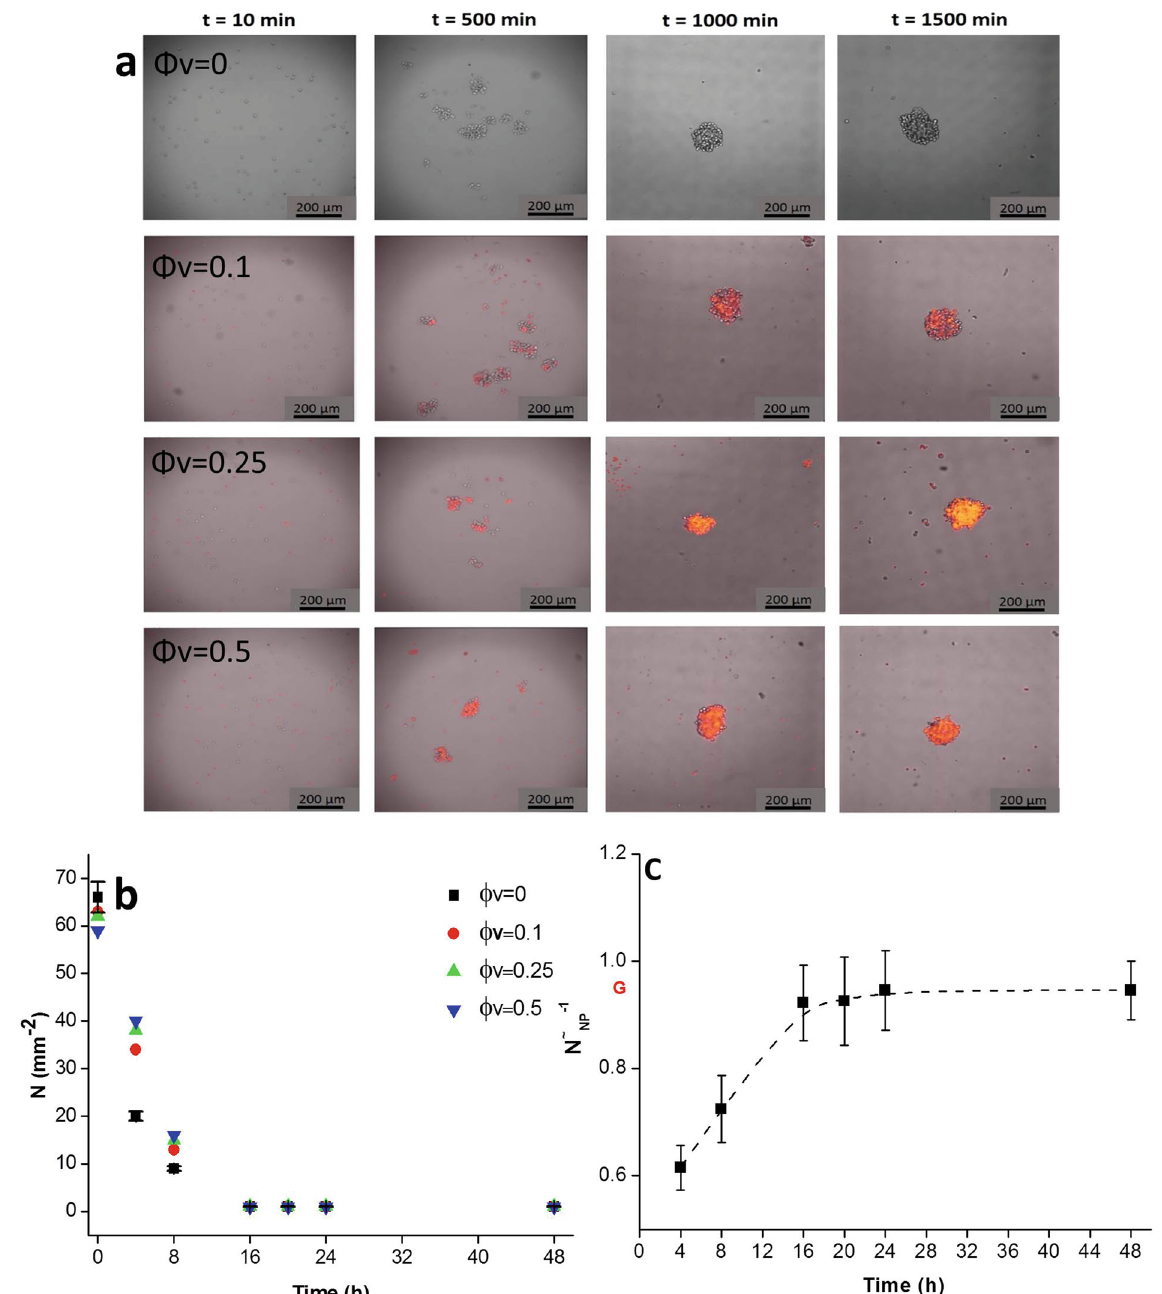
Fig. 5 Formation of hybrid aggregates using the pendant drop method. a Optical micrographs of droplets containing Ecad cells and Ps-10 microparticles (MPs) at times 10, 500, 1000 and 1500 min for volume fractions Φ V = 0, 0.1, 0.25, and 0.5. b Evolution of the number of clusters N per unit area over the incubation time, as counted in optical micrographs of droplets for four Φ V . c Plot of ~ N (cid:3) 1 for Φ V = 0.5, with ~ N (cid:3) 1 the ratio of the number of clusters without and with MPs. Error bars represent the standard deviation of n = 10 aggregates. G is the ef fi ciency